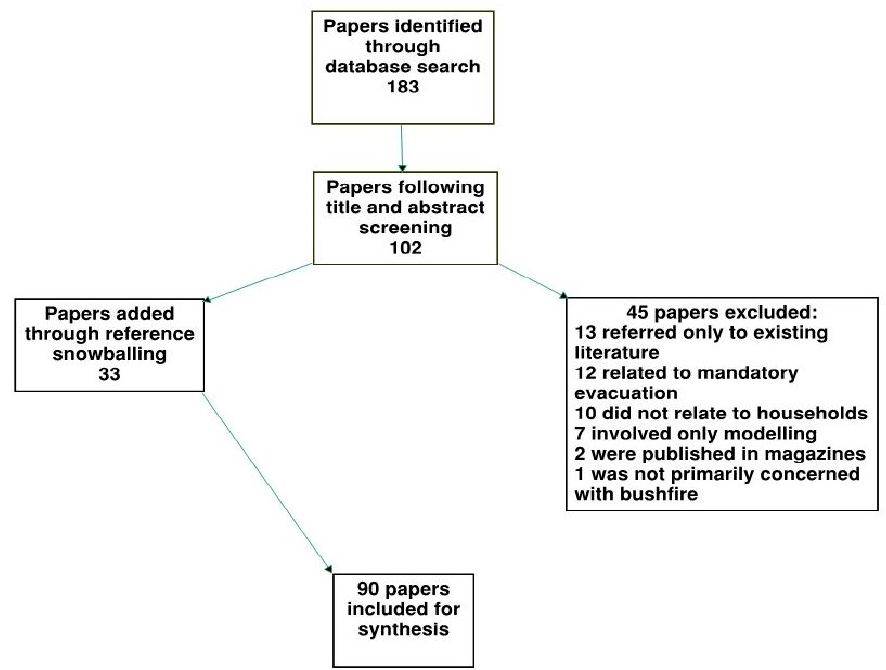
Figure 1. Flow chart showing details of literature search.